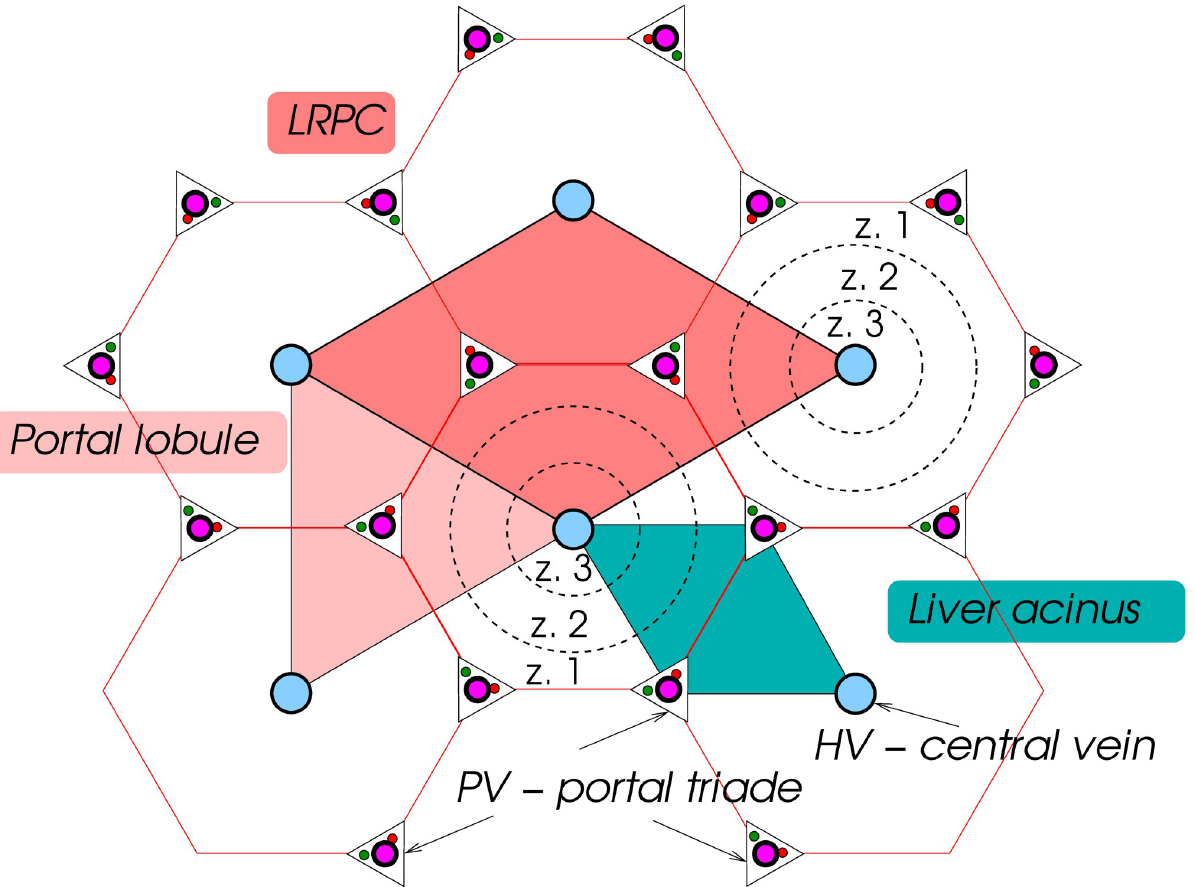
Fig 1. Liver microstructure and functional units. The liver representative periodic cell (LRPC) incorporates the Portal lobule and also the Acinus. Functional zones z. 1–3 are indicated.